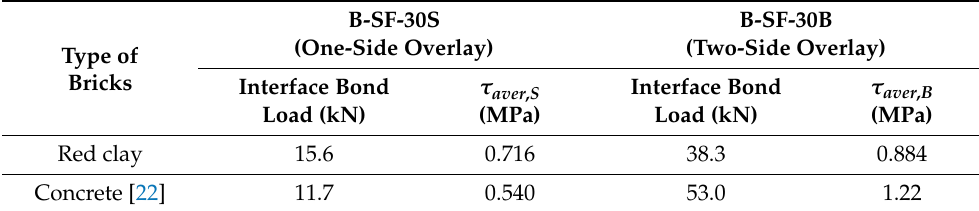
Table 7. Bond strengths for overlay-to-masonry